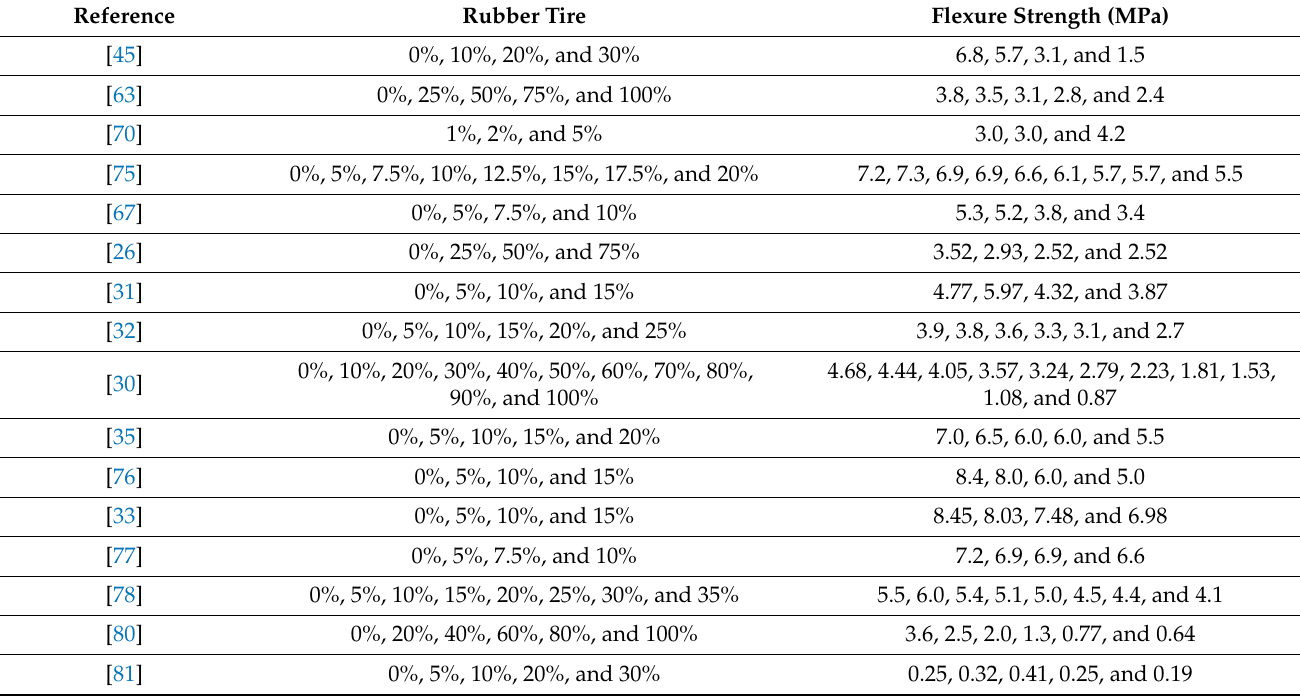
Table 4. Summary of flexural strength